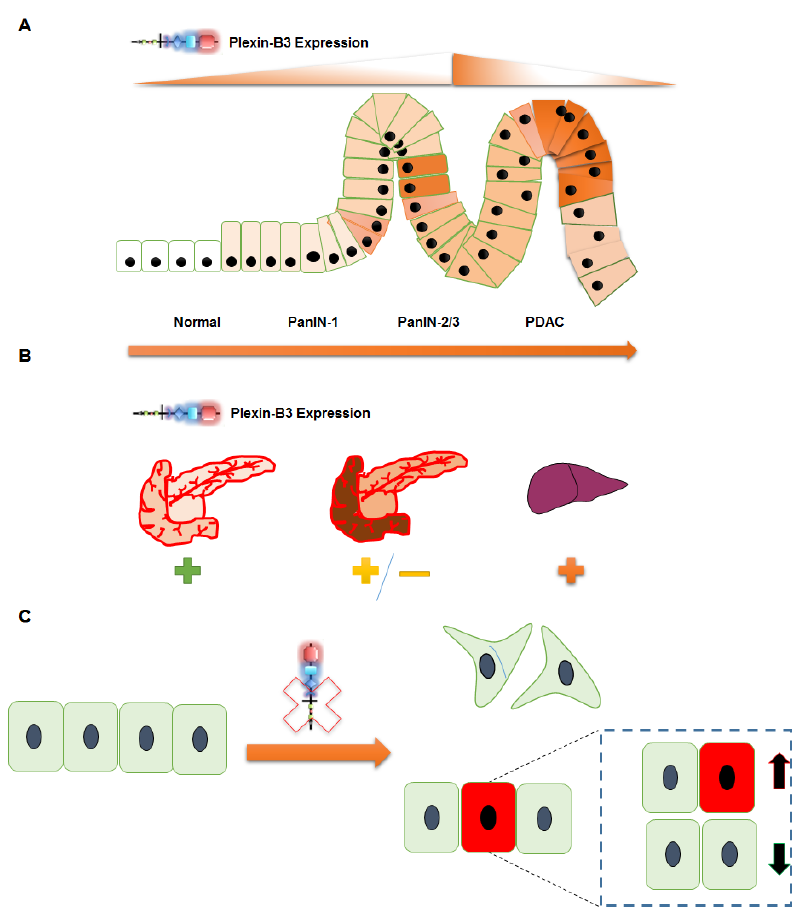
Figure 6. Schematic representation summarizing the role of Plexin-B3 in PC. ( A – C ) Plexin-B3 ex- pression analysis in different PC mouse models and human patient samples in a tissue microarray (TMA) suggests ( A ) an initial increase followed by a decrease in Plexin-B3 expression with PC progression. ( B ) Normal pancreas and different PC metastatic sites, like the liver, diaphragm muscles, and others, are positive for the expression of Plexin-B3. The expression of Plexin-B3 is stage-dependent in PC. ( C ) The loss of Plexin-B3 remodels the PC cellular shape, actin filaments, and enhances the invasiveness and migration abilities that facilitate metastasis. The loss of Plexin-B3 can directly or indirectly check cell division (represented by green color cells) and enhances stem cell-like PC cells (represented by red color cells).